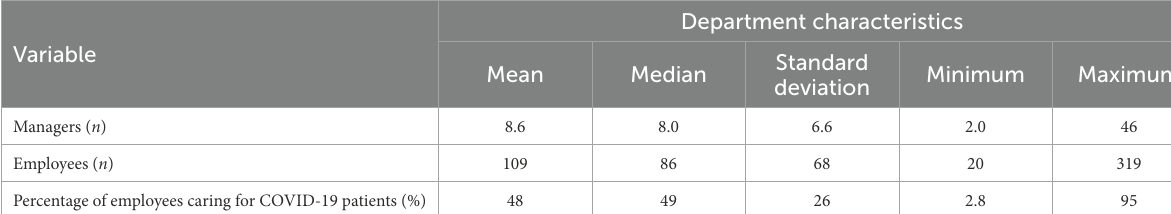
TABLE 2 Average number of managers, employees and COVID-19 exposure for the 55 departments during the first wave of the